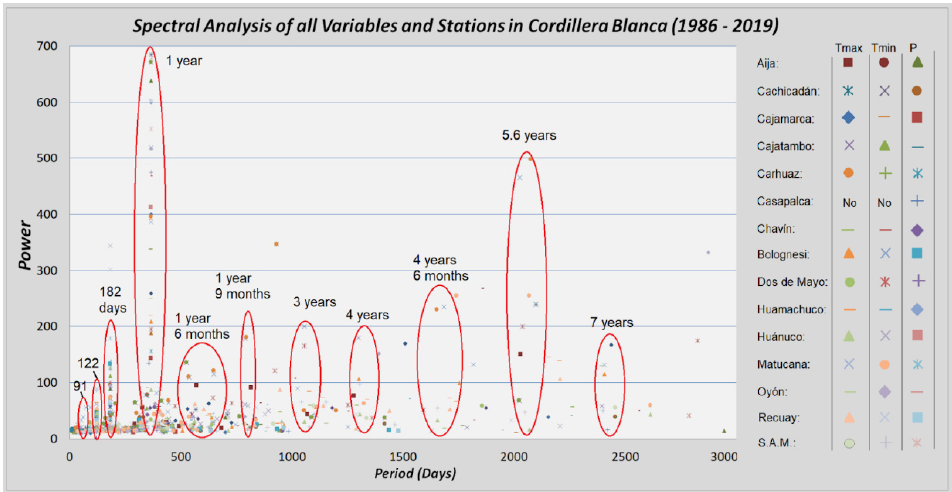
Figure 2. Results for the spectral analysis of each variable and each weather station.